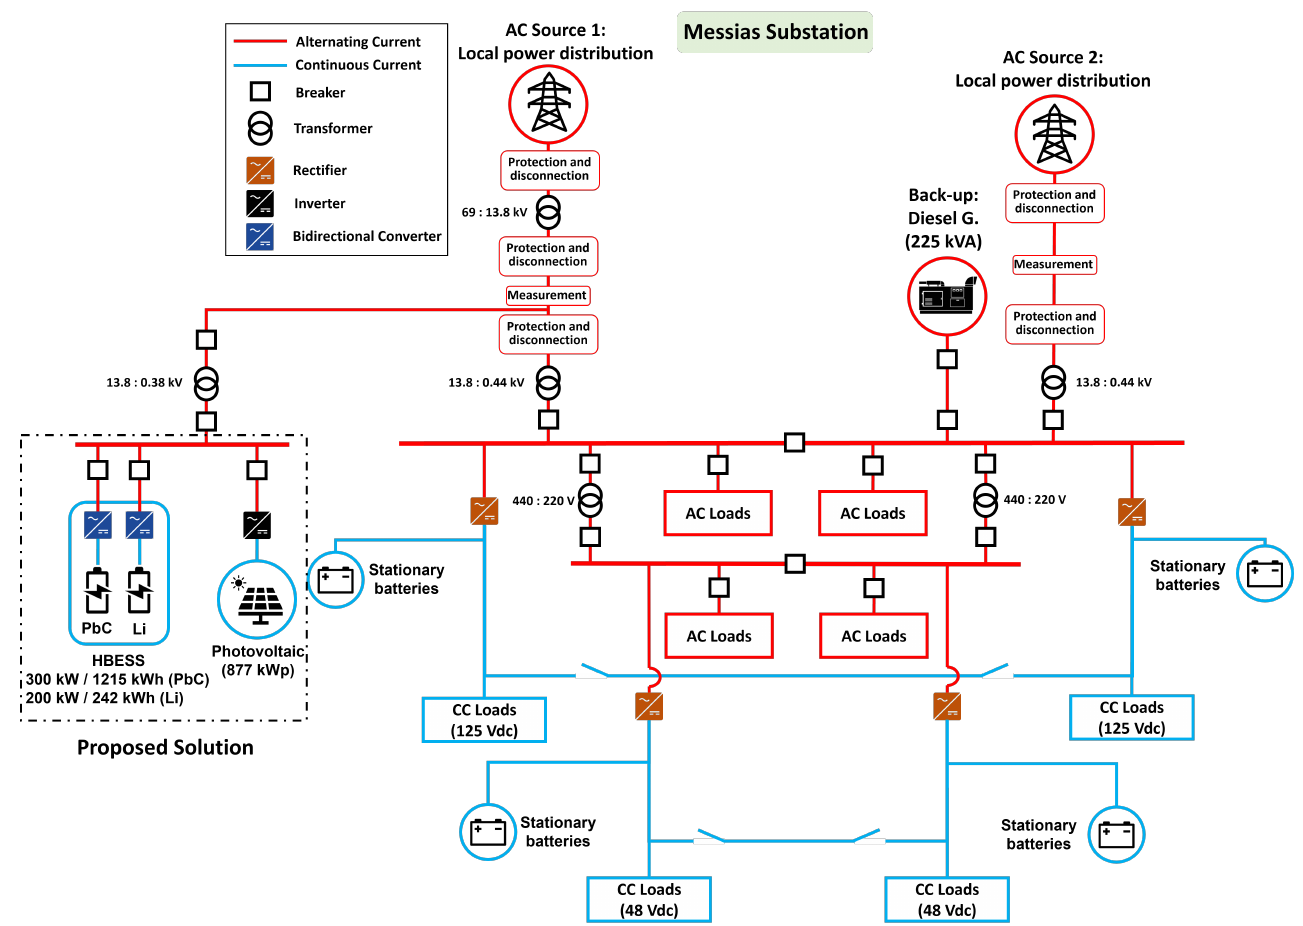
Figure 3. Simplified single-line diagram of the auxiliary system of Messias SS with the proposed